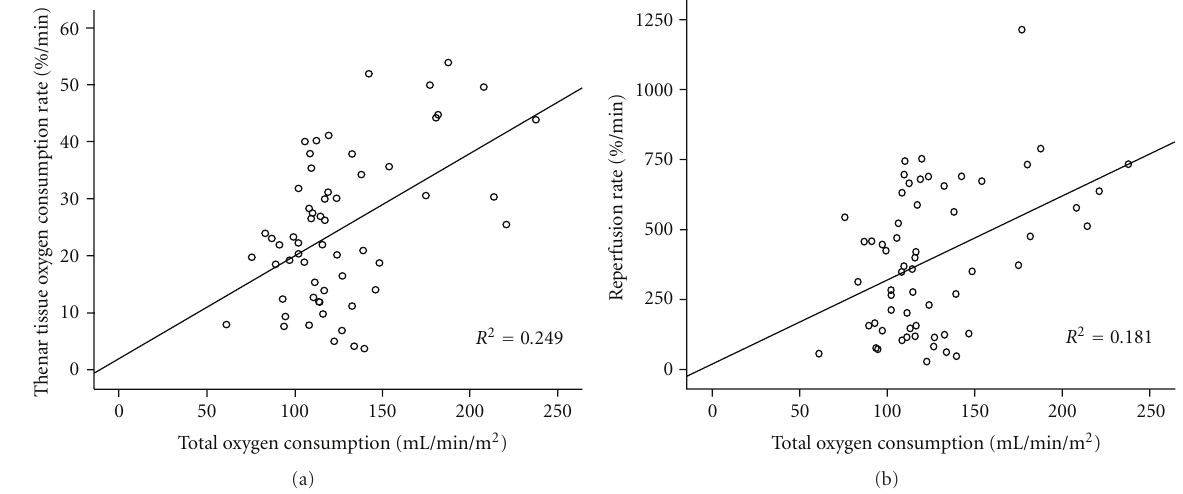
Figure 2: (a) Scattergram of the thenar tissue O 2 consumption rate (%/min) during a 3min vascular occlusion technique and total oxygen consumption (mL/min/m 2 , r = 0 . 50, P < 0 . 001, n = 60) for pooled data. (b) Scattergram of the reperfusion rate (%/min), indicative of, not or the endothelial function after cu ff release following a 3min vascular occlusion technique and total oxygen consumption (mL/min/m 2 ) ( r = 0 . 43, P < 0 . 001, n = 60) for pooled